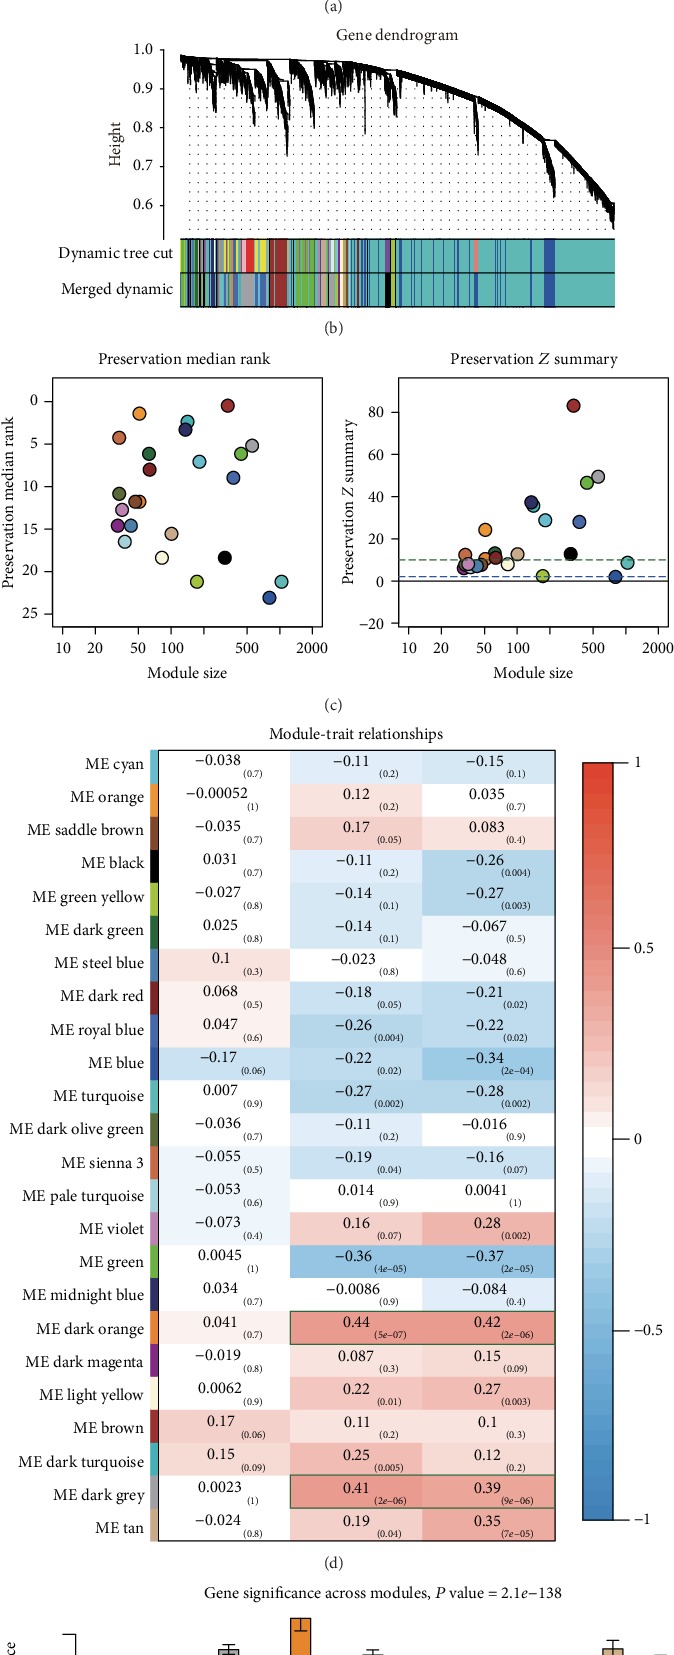
Weighted gene coexpression analysis for GSE73731. (a) Analysis of the scale-free fit index and mean connectivity for various soft-thresholding powers. (b) The clustering dendrogram based on the dissimilarity (1-TOM) using the dynamic tree cut method. (c) Module preservation test with an independent dataset, GSE53757. (d) Module-trait relationship heat map based on the Pearson correlation coefficient between module eigengenes and clinical parameters (age, grade, and stage). (e) Barplot for average gene significance across modules associated with the pathological stage for ccRCC.